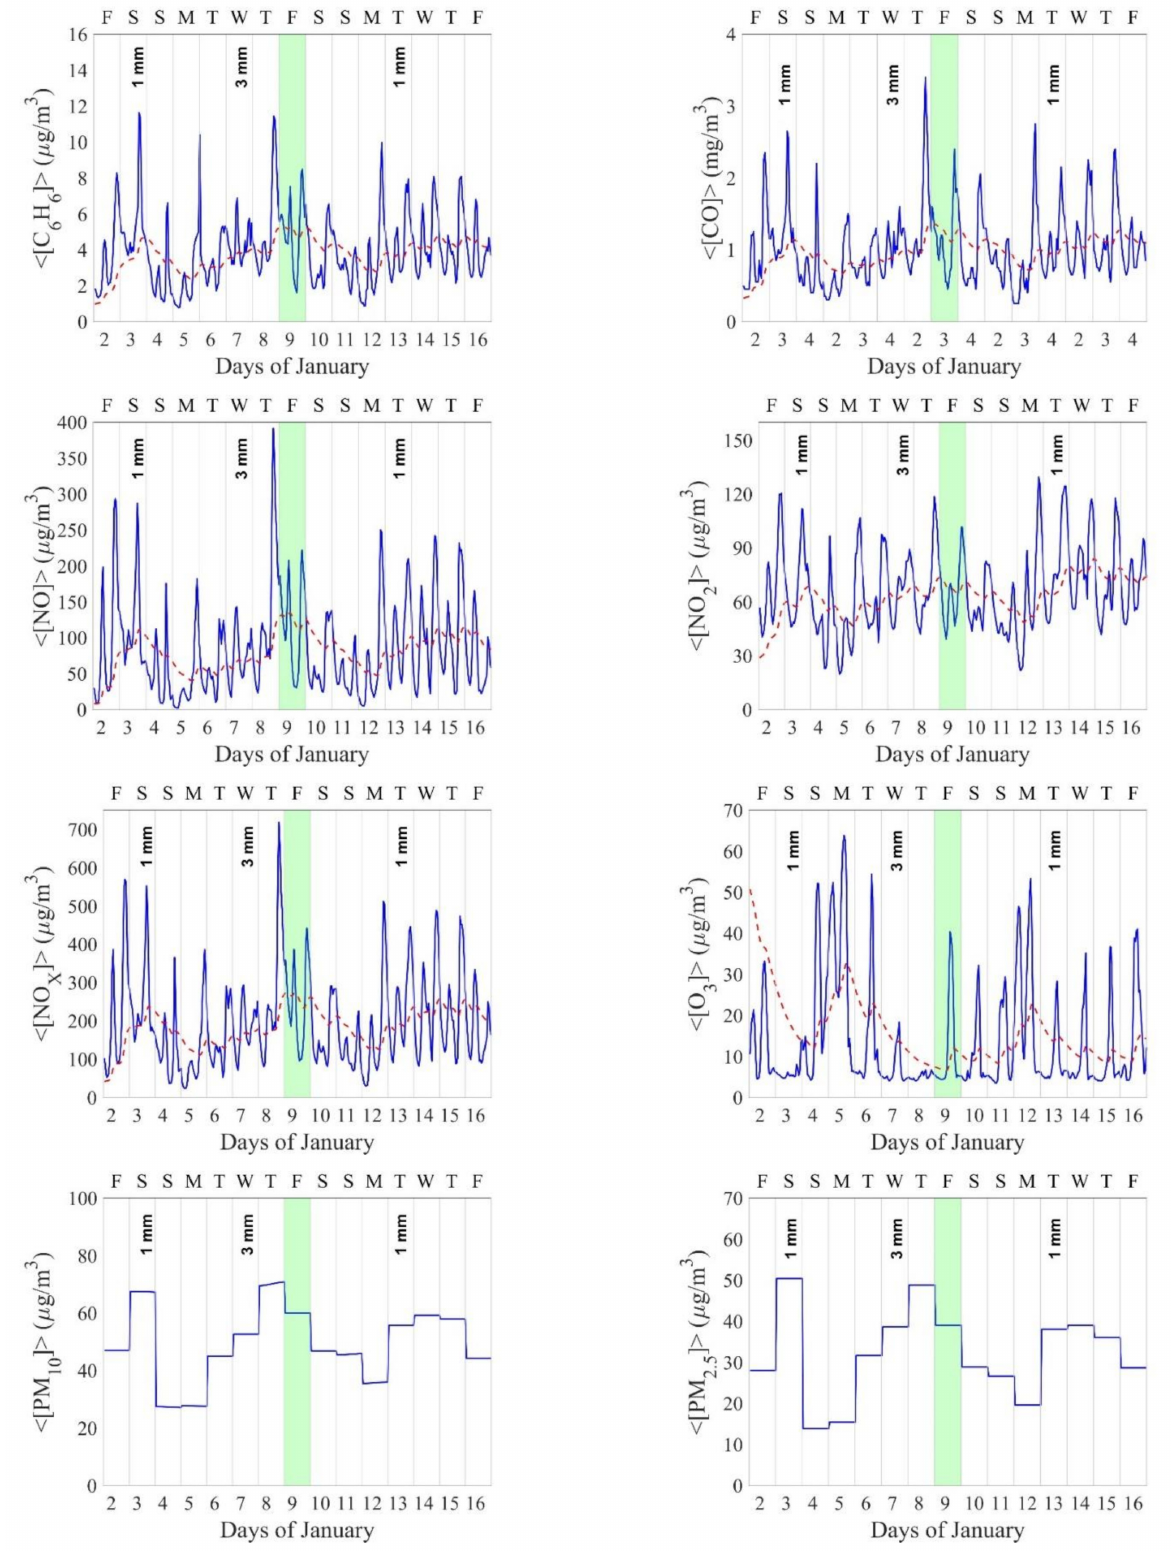
Figure 5. Pollutant concentration variation related to the total block of urban traffic of 9th January 2015 (green band). The blue line is the hourly pollutant concentration. The Red dashed line is the daily mean pollutant concentration. Data of daily precipitation are indicated in